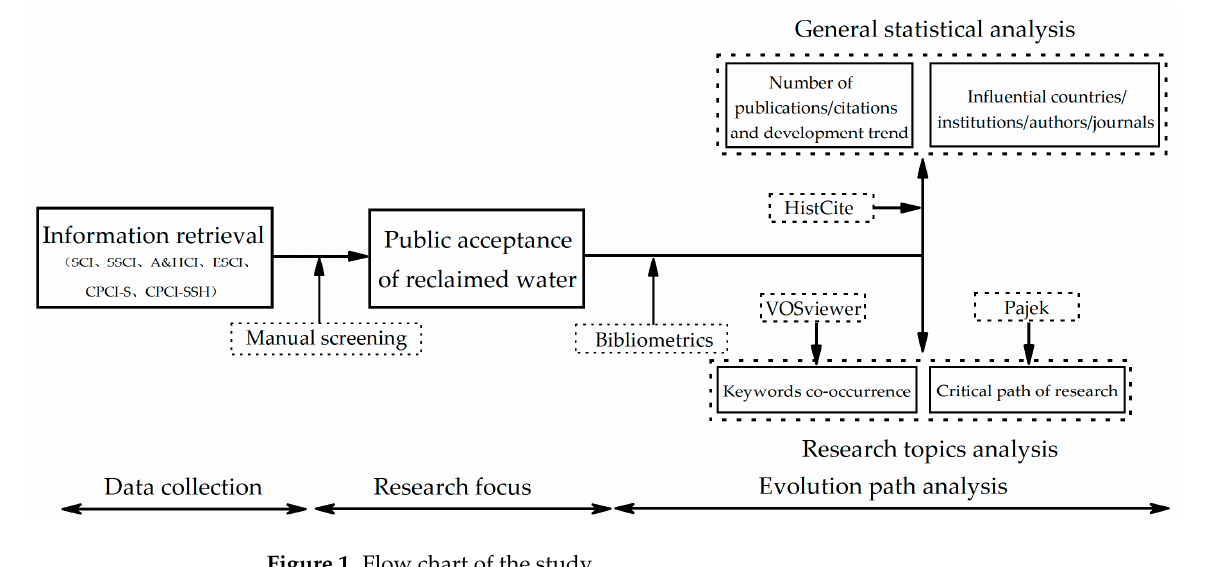
Figure 1. Flow chart of the study.